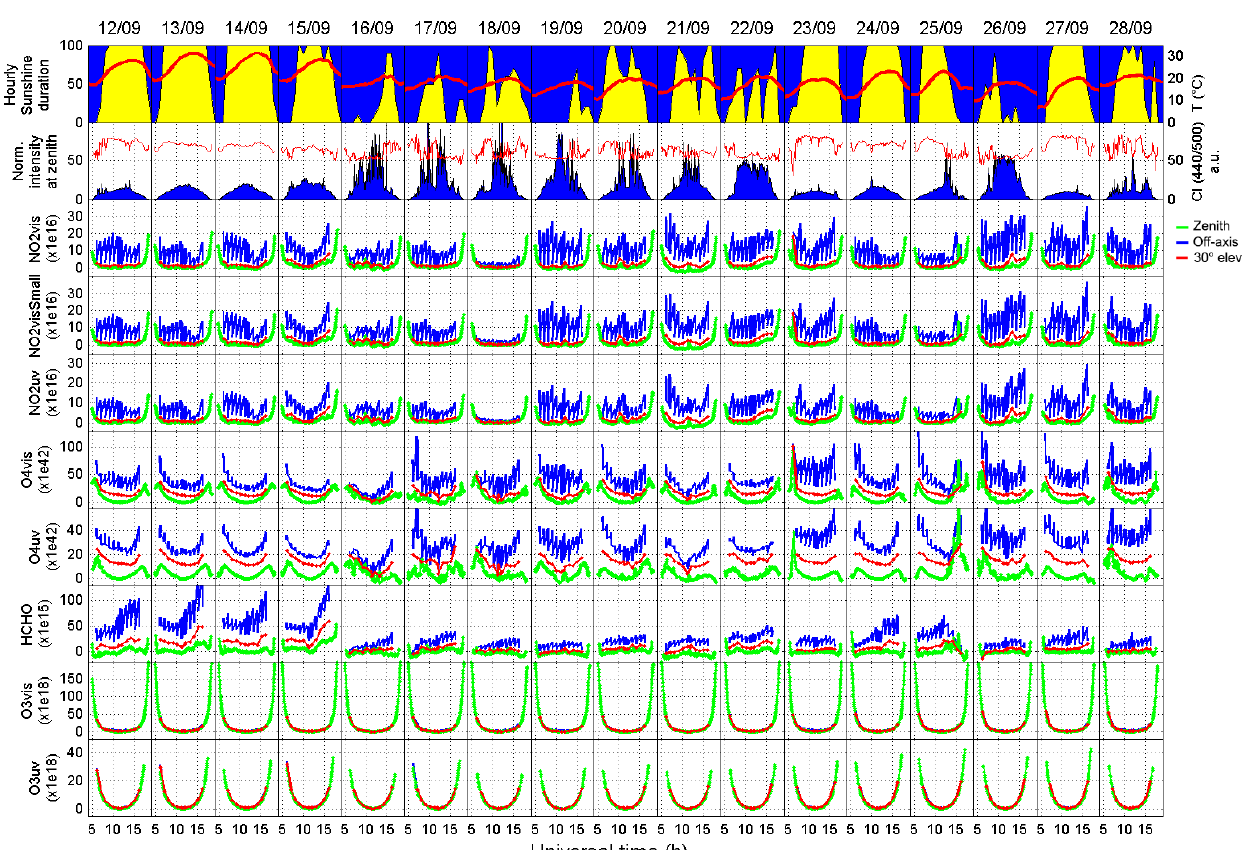
Figure 3. Hourly sunshine duration (yellow area) and temperature at the surface (red line) during the intensive campaign (topmost row), the intensity measured in the zenith and the colour index (second row from top), and the variability of the various trace gas slant column measurements performed during the semi-blind intercomparison exercise (all other rows). Slant column data measured at the main azimuth viewing direction (287 ◦ ) with the IUP-Bremen instrument (iupb-18) are shown. Green lines and symbols represent zenith-sky measurements, red lines and symbols off-axis data at 30 ◦ elevation, and blue lines off-axis measurements up to 15 ◦